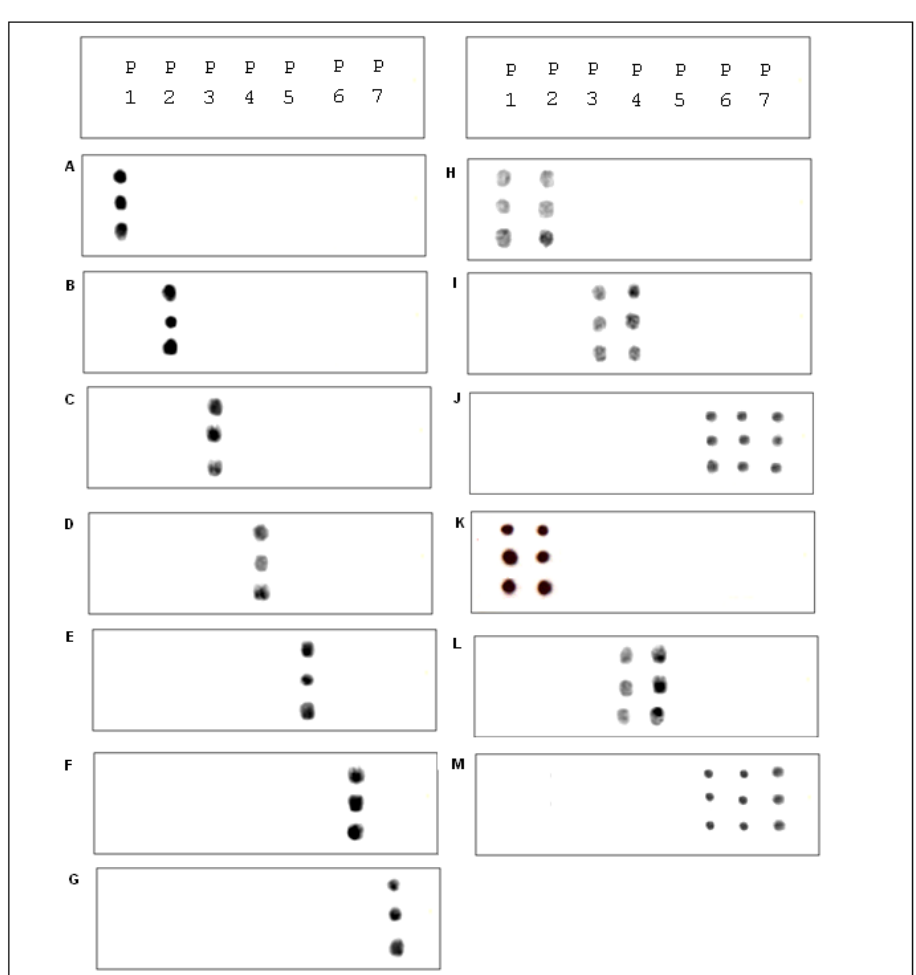
Figure 6. The same set of probes were used on each hybridization pattern of